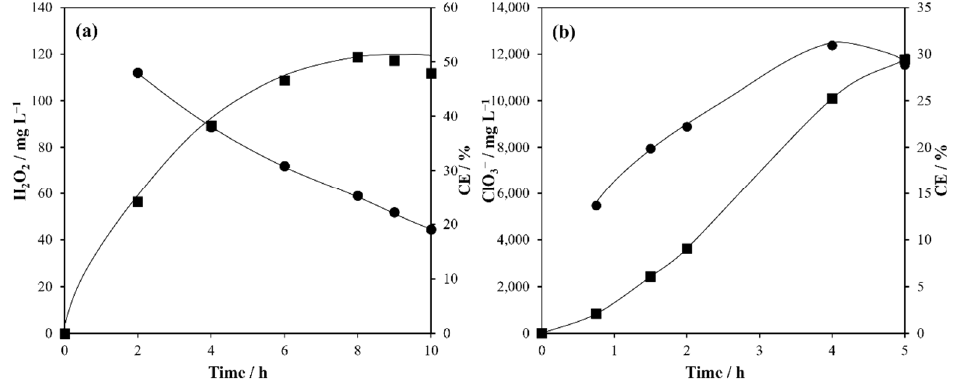
Figure 5. Electrochemical production of hydrogen peroxide in 3000 mg L − 1 HClO 4 ( a ) and chlorate in 20 g L − 1 NaCl ( b ). Symbols: ( ■ ) concentration (mg L − 1 ), ( ● ) current e ffi ciency (CE/%). Samples of the hydrogen peroxide produced were taken at applied charges of 0.71 Ah L − 1 (8 h and 118.8 mg L − 1 H 2 O 2 ) and were mixed with samples of chlorate obtained after pass- ing 48.44 Ah L − 1 (4 h and 10,100.1 mg L − 1 ClO 3 − ). The first also contains